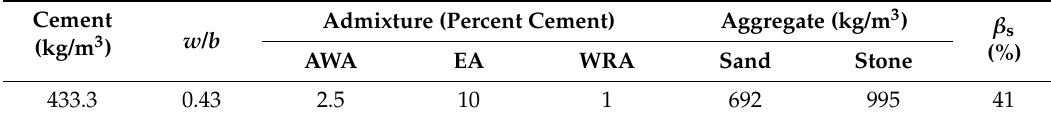
Table 20. The optimal mix ratio of SSAWC (kg/m 3